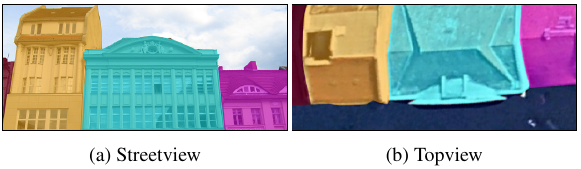
Figure 1. An example of typical houses in Berlin, Germany, taken from Google Earth. Each color represents a different building section, where all sections belong to the same building